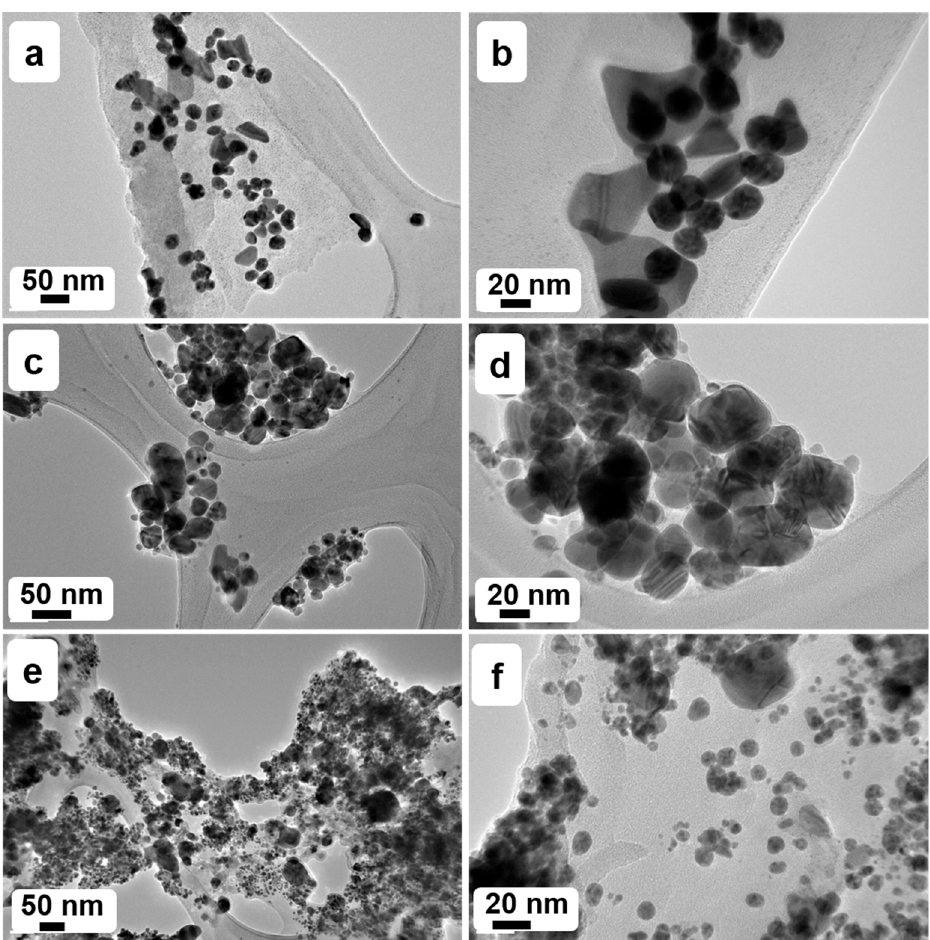
Figure 5. TEM images showing the morphologies of Au ( a , b ), Ag ( c , d ), and Au–Ag alloy ( e , f ) NPs using high concentrations of PE.